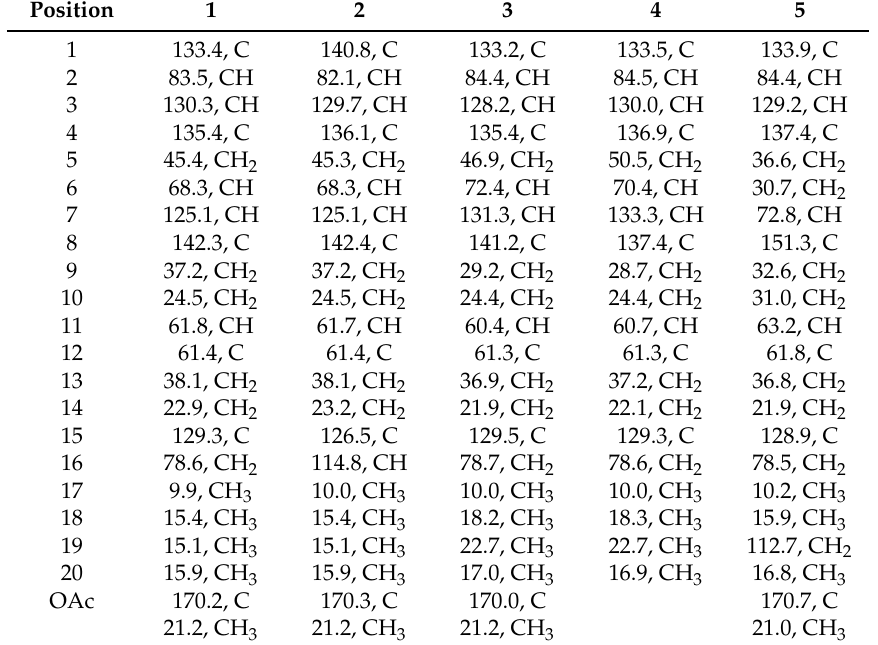
Table 2. 13 C-NMR spectroscopic data of 1 – 5 in CD 3 COCD 3 (100 MHz, δ in ppm, J in Hz).